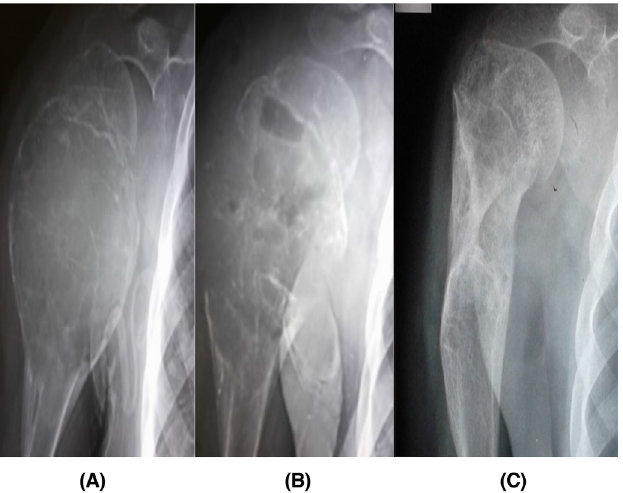
Figure 3. Serial plain radiographs (A) 11 years old patient with ABC lesion in the proximal humerus (case 9), (B) 4 weeks follow- up after endoscopic curettage without grafting showed new bone formation, and (C) complete healing and remodeling after 24 months.